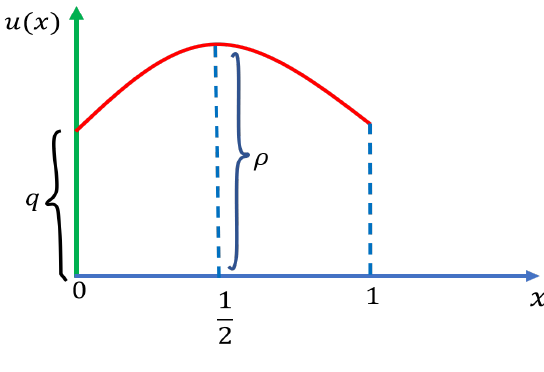
Fig. 9: The shape of the solutions of (5.1) .